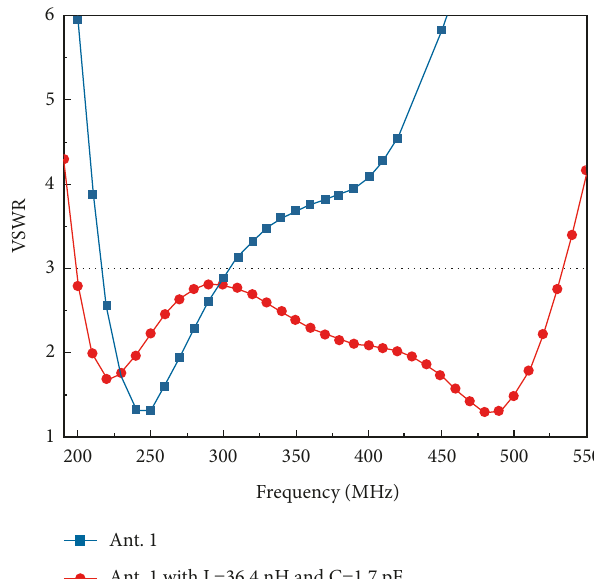
Figure 6: The simulated VSWR of Ant. 1 and Ant. 2 with the matching circuit composed of L